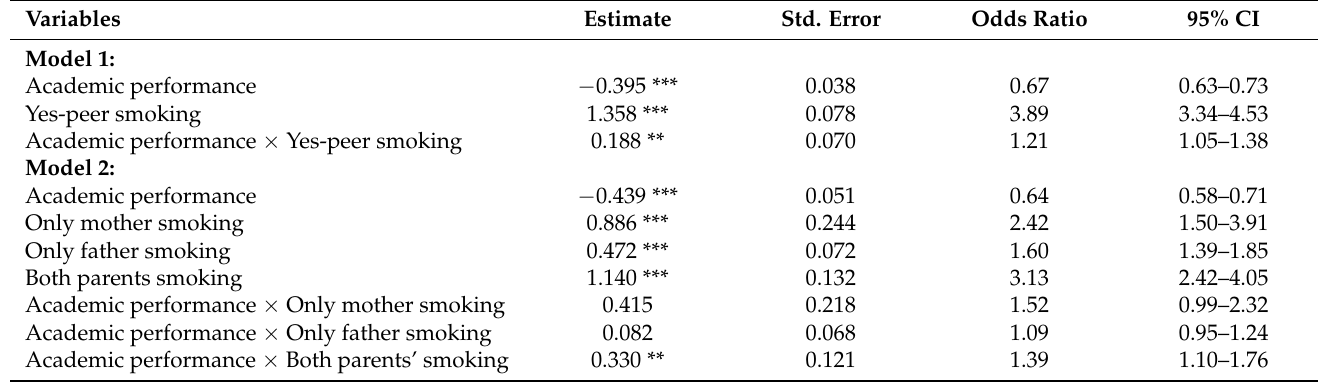
Table 4. Logistic models examining interactions on intention to smoke among non-smoking